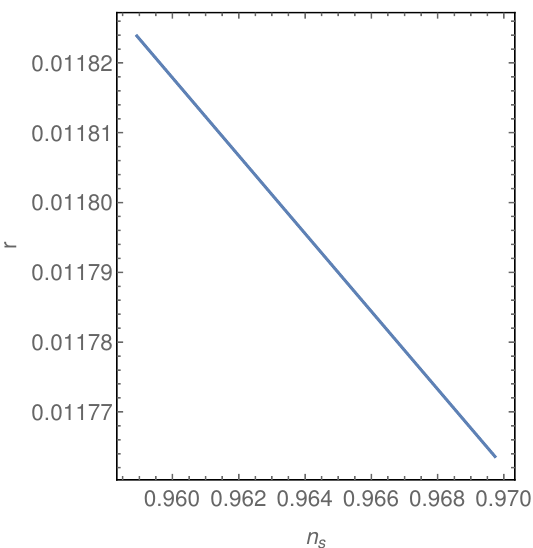
Figure 4. Parametric plot of n s (along the x -axis) vs. r (along the y -axis) with respect to n . Here, f 0 = 1, a 0 = 4, and n = ( 0.3062,0.3065 )